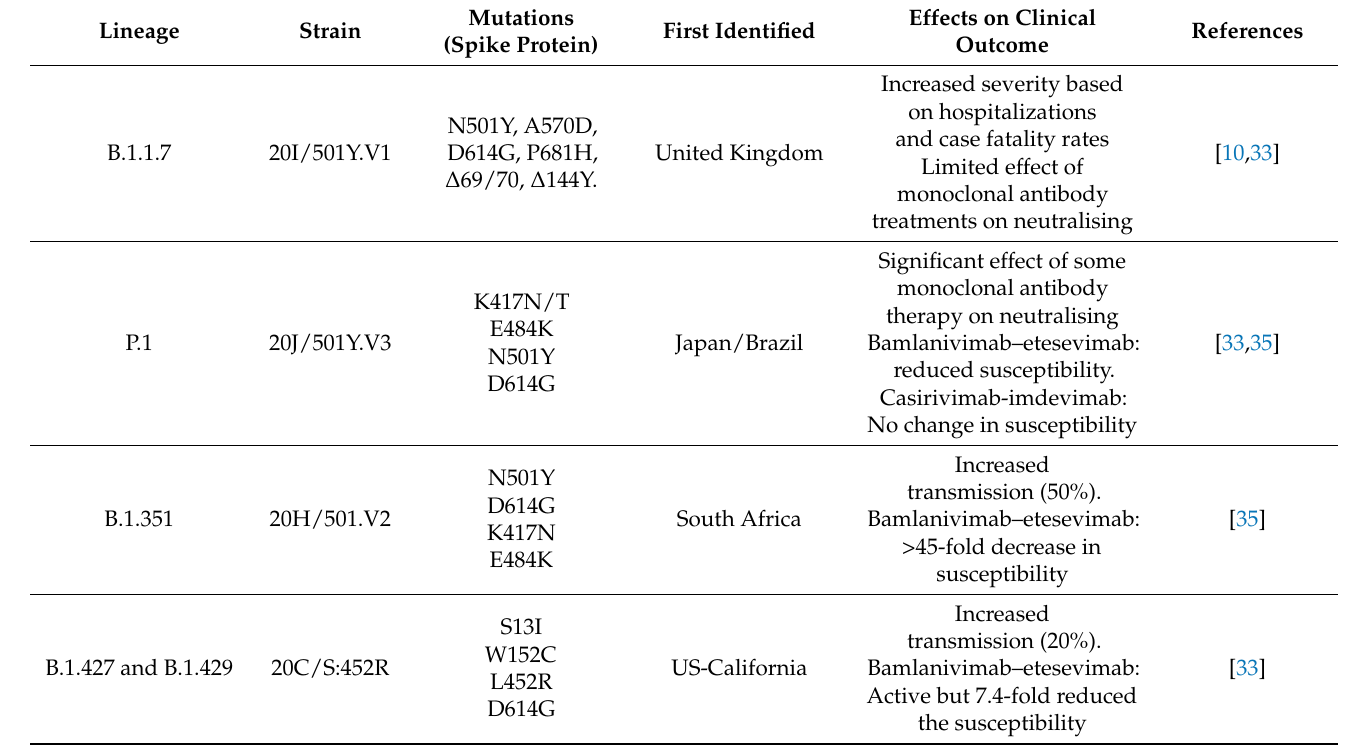
Table 2. SARS-CoV-2 variants and their effects on clinical outcome.